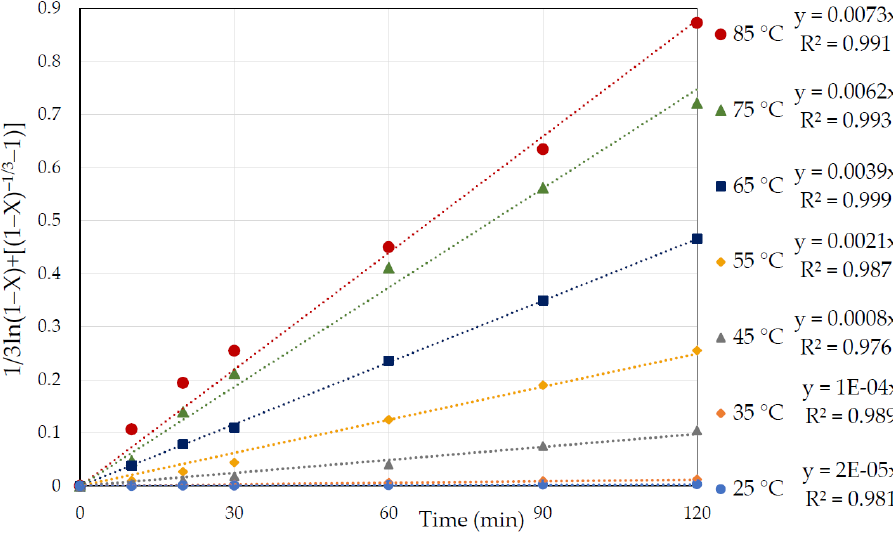
Figure 9. Graphs of 1/3ln (1 − X) + [(1 − X) − 1/3 − 1] = k.t vs. time (min) at various temperatures of 25 to 85 °C for the dissolution of pyrite in 3 M nitric